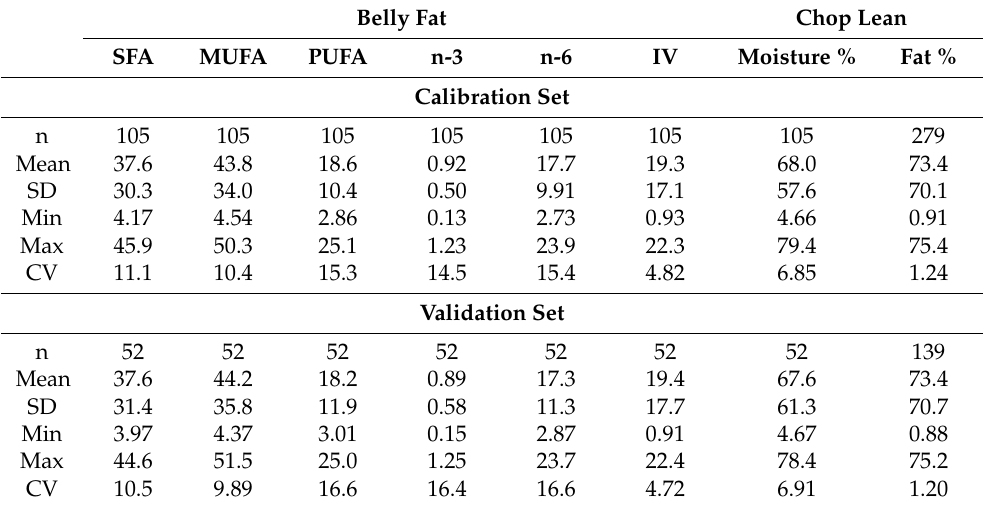
Table 2. Descriptive statistics for fatty acid parameters, iodine value of belly fat samples (n = 158), and moisture and fat composition of chop lean samples (n = 418) for calibration and validation sets. Belly Fat Chop Lean SFA MUFA PUFA n-3 n-6 IV Moisture % Fat % Calibration Set n 105 105 279